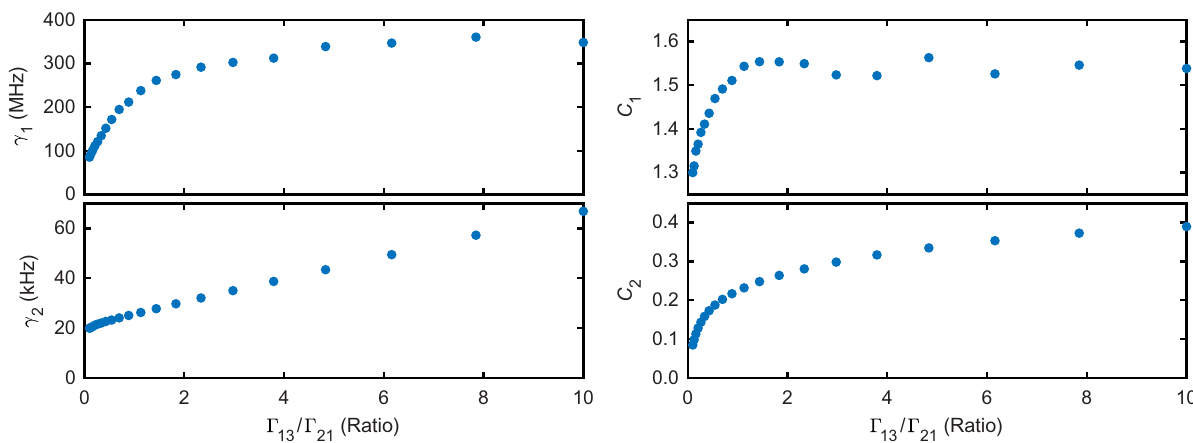
FIG. 14. Simulating optical dynamics of QE A. Antibunching and bunching parameters resulting from simulation of the model discussed in the main text by setting the radiative and nonradiative rates to best recreate the observed optical dynamics of QE A. The simulation is using the parameters discussed in the text: (cid:8) 21 = 300 MHz, (cid:8) 32 = 60 MHz, (cid:8) 12 = 0 MHz, κ 24,0 = 24 kHz, β 24 = 9 kHz, = 18 kHz, and β = 3 kHz. The results are plotted as a function of (cid:8) κ 41,0 41